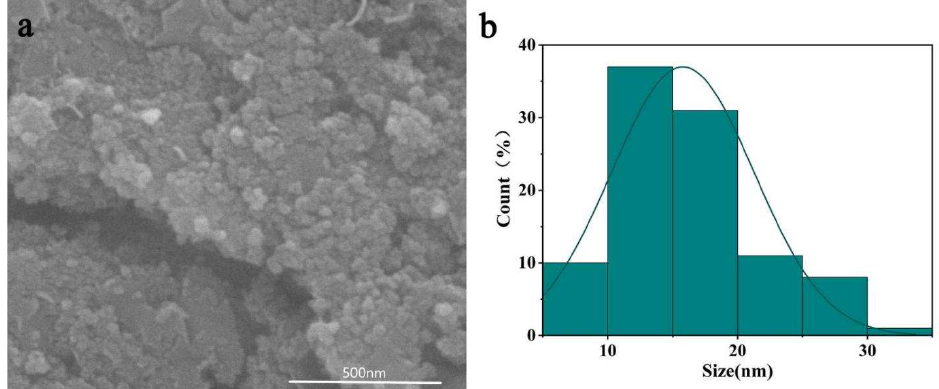
Figure 3. ( a – d ) Scanning electron microscopy images of 30%-TM at different magnifications.